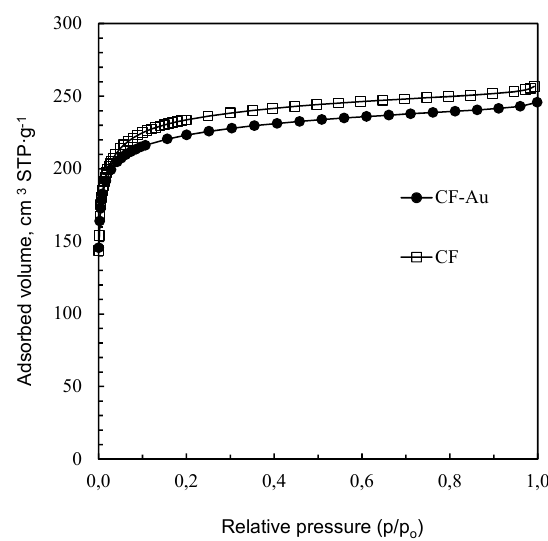
Figure 2. N 2 adsorption isotherms at − 196 °C of CF and CF-Au.